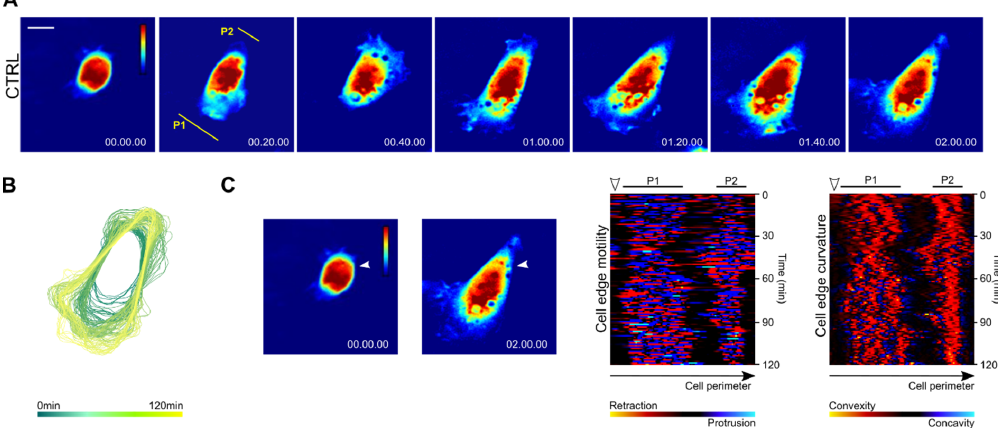
Figure 3. Development of a stable cell rear and front in spreading Rat2 fibroblasts. ( A ) Series of pseudo-colored quantitative images selected from time-lapse CCHM showing protruding and retracting areas in a control Rat2 cell spreading on fibronectin. Time is indicated in h.min.s. P1 and P2 indicate protrusive cell poles 1 and 2, respectively. ( B ) The time sequence of the cell outline during spreading of a control cell superimposed from the first image to the last image. ( C ) Cell edge motility and convexity maps of a spreading cell created in QuimP plugin for ImageJ. The motility map represents changes in the movement speed of the cell edges between two time points. Blue colors indicate expanding regions (protrusions) and red and yellow colors contracting regions (retractions). The convexity map represents the changes in the curvature of the cell edges in time with negative (concave) regions in blue and positive (convex) regions shown in red-yellow. The first and last images of a spreading control cell are displayed in the left panels, white arrows indicate the start point of the cell outline. Scale bar 10 μm.